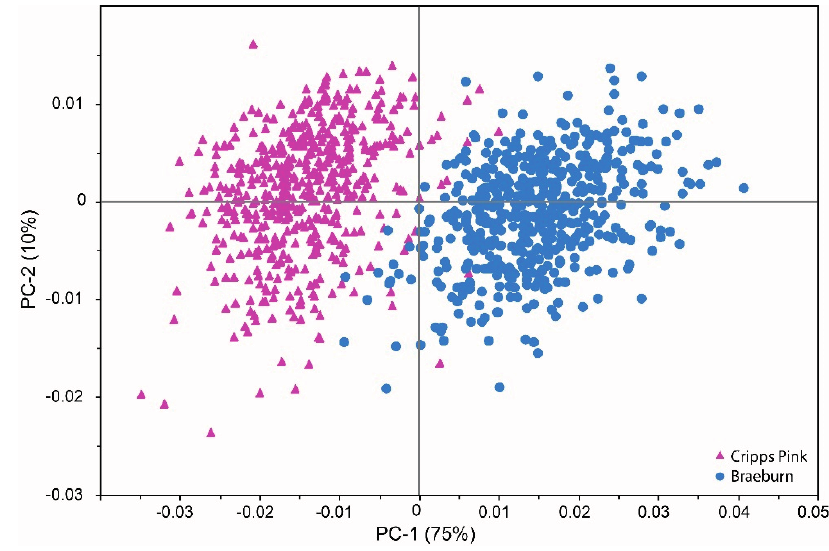
Figure 1. PCA score plot NIR data acquired from the complete data set (515 “Braeburn” and 534 “Cripps Pink”